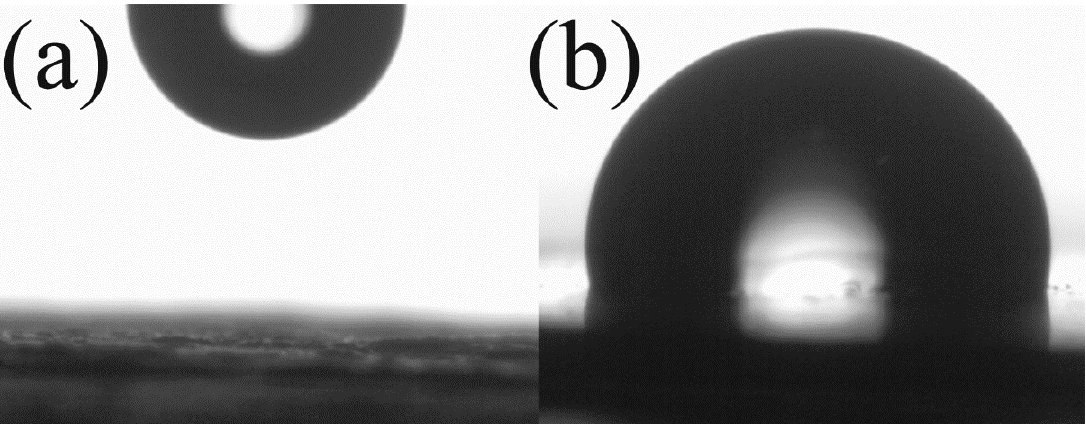
Figure 6. Contact angle measurements using sessile drop method of neat GO ( a ) and GO-PBA ( b ).